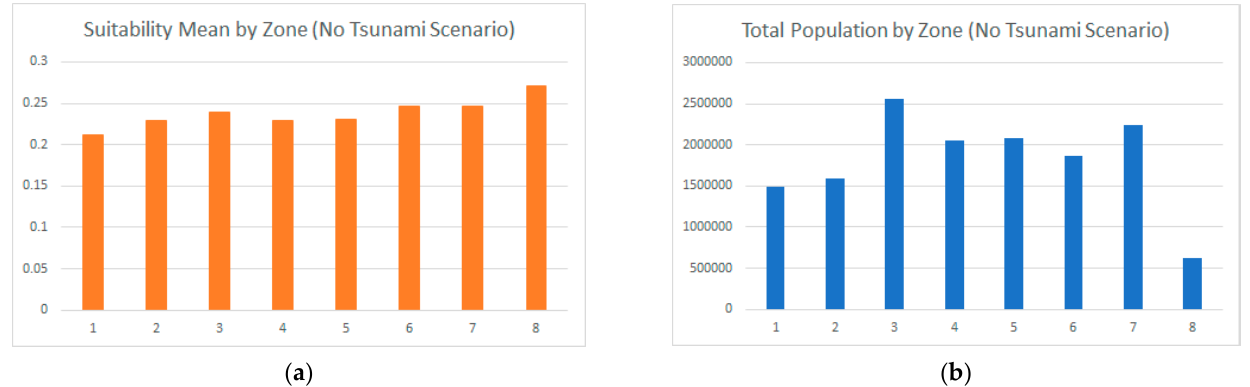
Figure 6. ( a ) Suitability Mean and ( b ) Total population by Zone in No Tsunami Scenario.